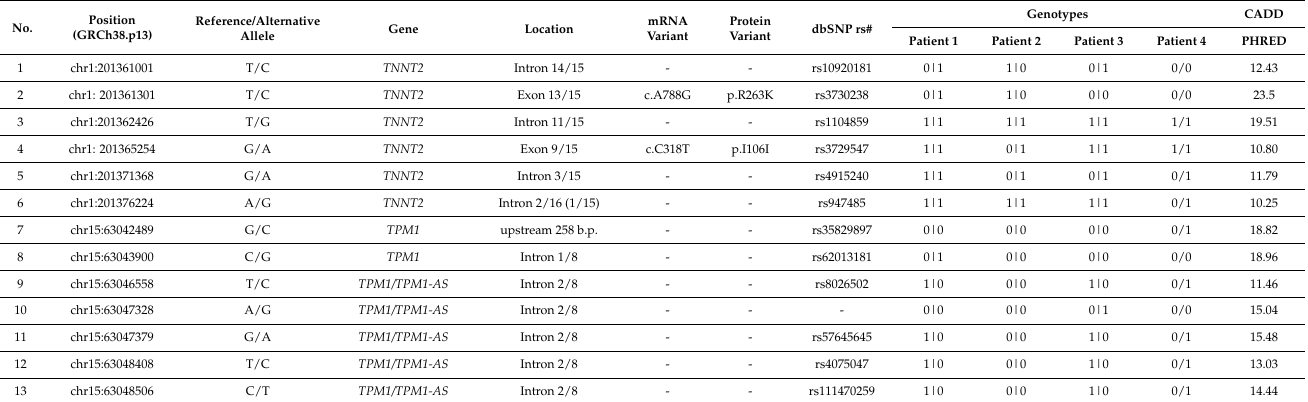
Table 3. Phased genotypes in genes TNNT2 and TPM1